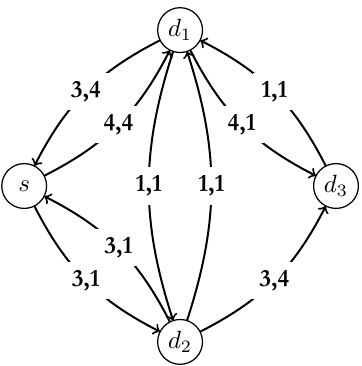
Figure 1: Evacuation Network with arc labels capacity, travel time